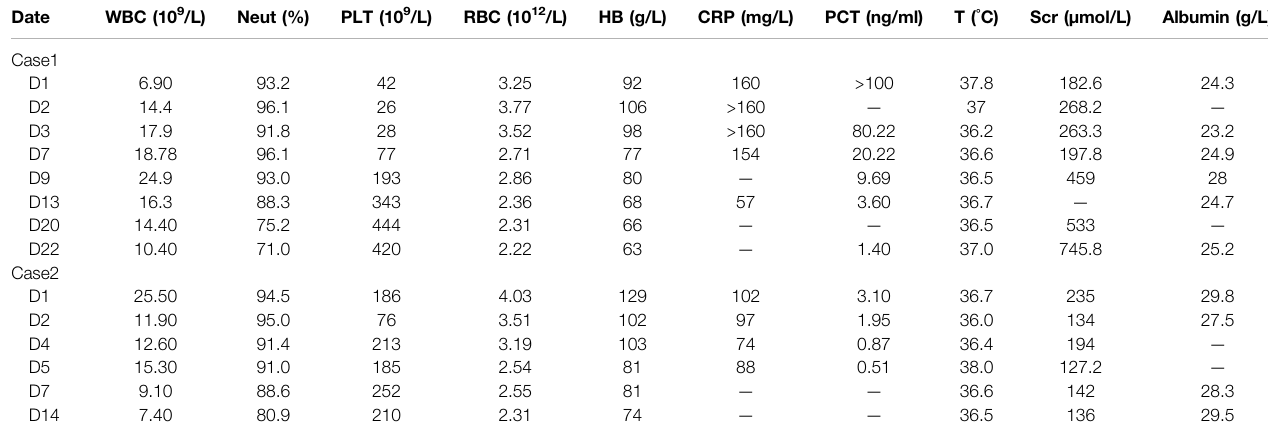
TABLE 3 | Laboratory tests and results of patients during